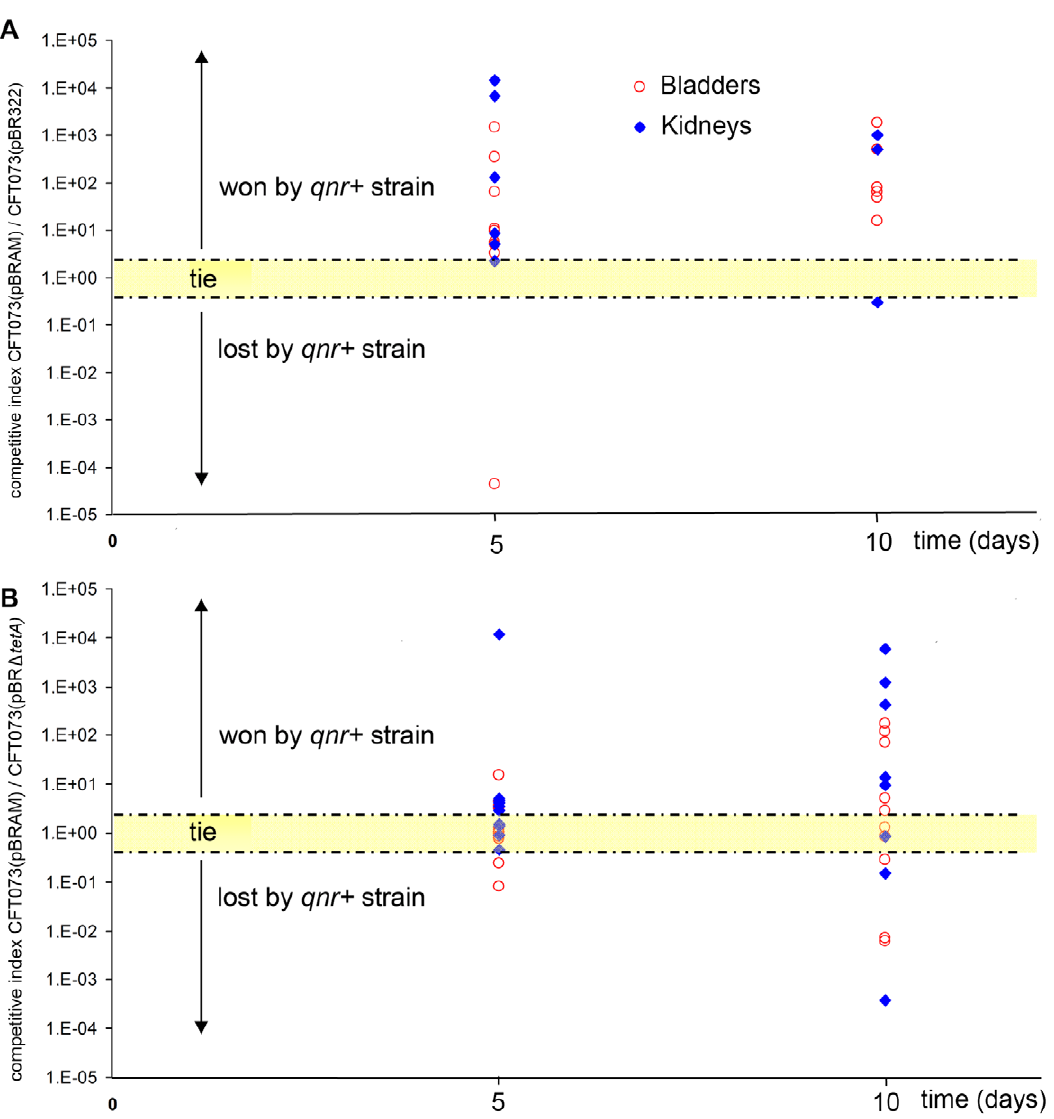
Figure 2. Enhanced fitness observed in competitive infections for E.coli CFT073 after qnrA3 acquisition onto pBR322. Each symbol represents the bacterial ratio (number of CFU for the qnr -positive strain/number of CFU for the qnr -negative isogenic strain) measured in organs (blue diamond=kidneys, red circle=bladder) collected five and ten days after inoculation of a 1:1 mix of the two strains. When the ratio was equal to 1 + / 2 0.2, it was considered as tie. Part A: competitions experiments opposing E. coli CFT073(pBR322) ( qnr 2 , tetA + ) and E. coli CFT073(pBRAM2) ( qnrA3 + , tetA 2 ). Fifteen mice were inoculated, 15 bladders and 10 pairs of kidneys were efficiently infected. Competition was won 22 times by E. coli CFT073(pBRAM2) ( qnrA3 + , tetA 2 ), was lost 2 times, and one was tie (p , 0.0001). Part B: competitions opposing E. coli CFT073(pBR D tetA ) ( qnr 2 , tet 2 ) and E. coli CFT073(pBRAM2) ( qnrA3 + , tet 2 ). Twenty-three mice were inoculated, 20 bladders and 17 pairs of kidneys were efficiently infected. Competition was won 24 times by E. coli CFT073(pBRAM2) ( qnrA3 + , tetA 2 ), was lost 9 times, and 6 was tie (p ,